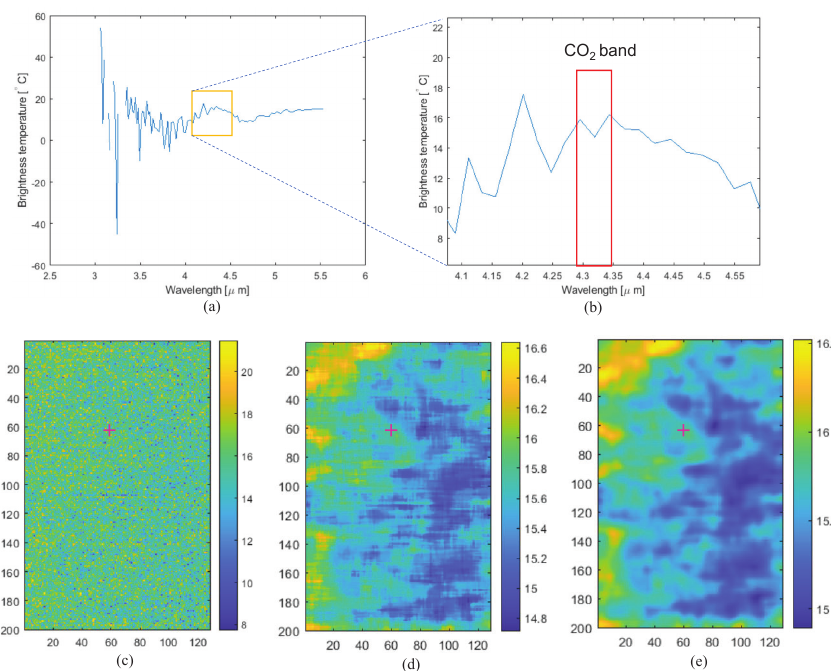
Figure 10. Brightness temperature extraction and VisualAT results: ( a ) brightness temperature; ( b ) enlarged brightness temperature with CO 2 band region; ( c ) CO 2 band image; ( d ) median filtered image; ( e ) Gaussian filtered temperature